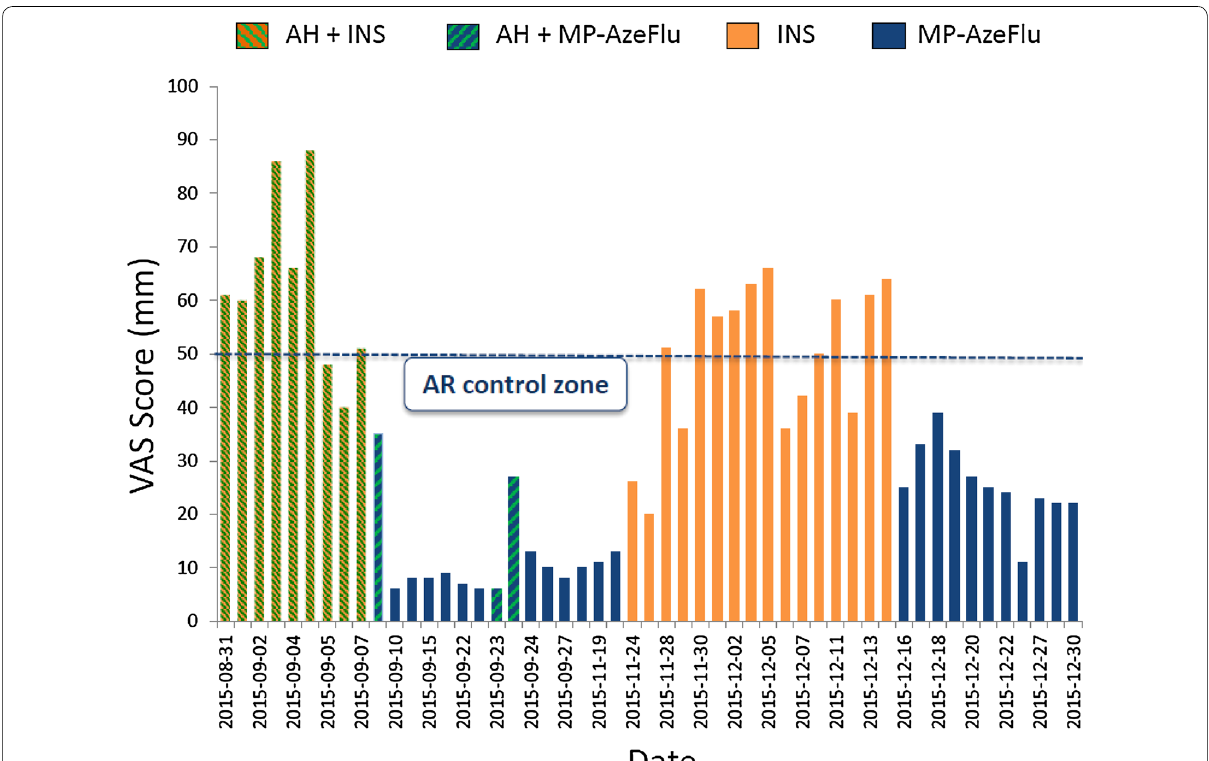
Fig. 1 Allergic rhinitis (AR) control according to treatment in a single Allergy Diary user. VAS: visual analogue scale; AH: anti-histamine; INS: intranasal corticosteroid; MP-AzeFlu (MP-azelastine/fluticasone propionate); AR: allergic rhinitis. Reprinted with permission from